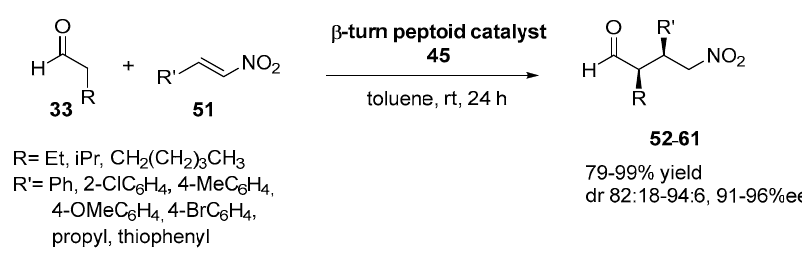
Figure 7. Structures of β -turn peptoids 44 – 48